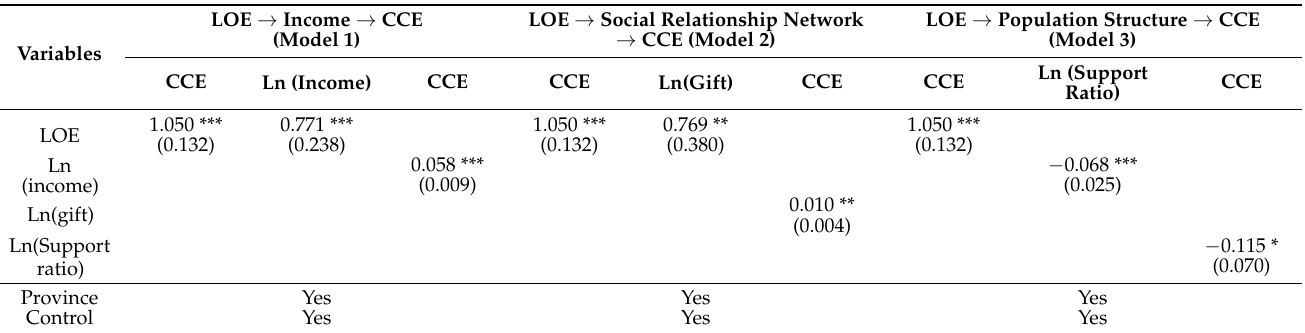
Table 4. Influence mechanisms of off-farm employment on clean energy